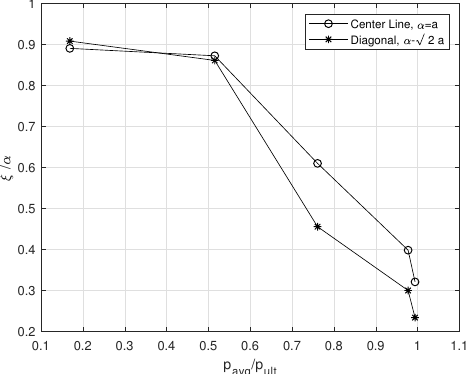
Figure 7. Analysis of peak locations versus applied average pressure from the curve-fit pressure surfaces of Equation